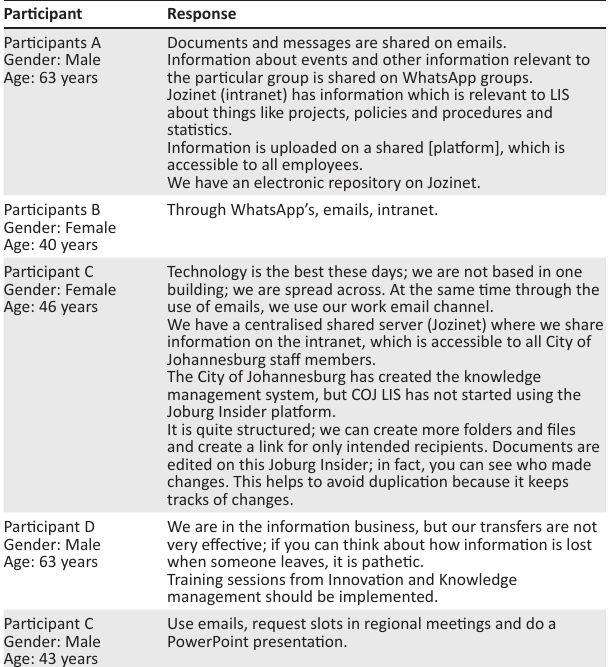
TABLE 2: Knowledge sharing in City of Johannesburg Library and Information